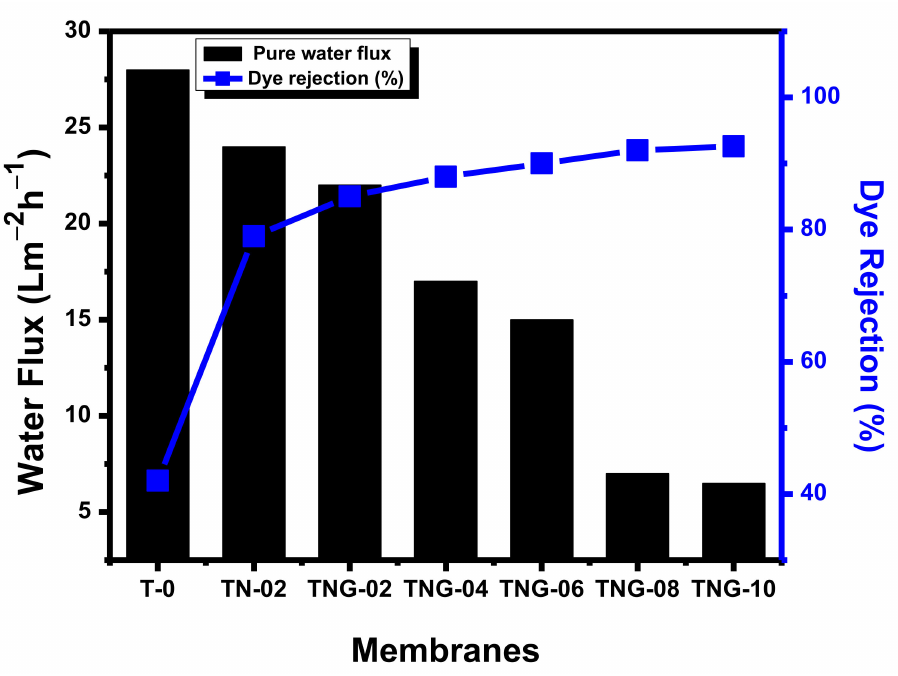
Figure 11. Pure water flux and MO rejection of TPU based membranes with different NiO/NH 2 -GO